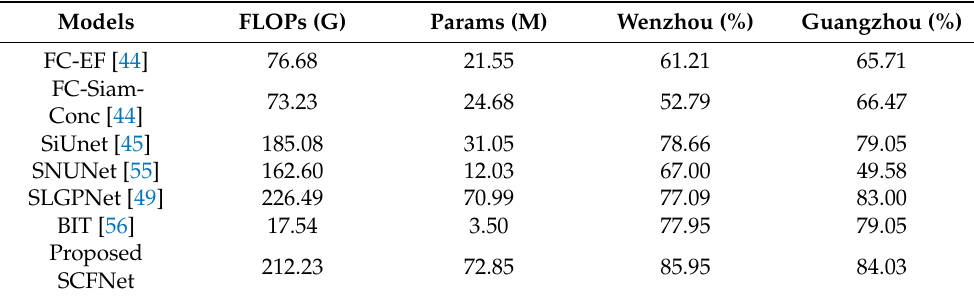
Table 5. Quantitative comparison of the performance (in F1-Score) and computational costs of different